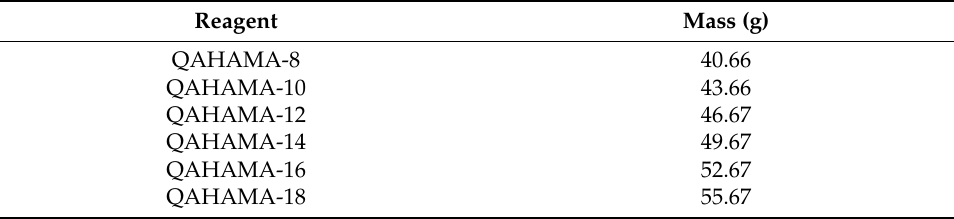
Table 4. Weights of QAHAMAs used in the addition reaction with TMDI (formation of QAUDMAs). Reagent Mass